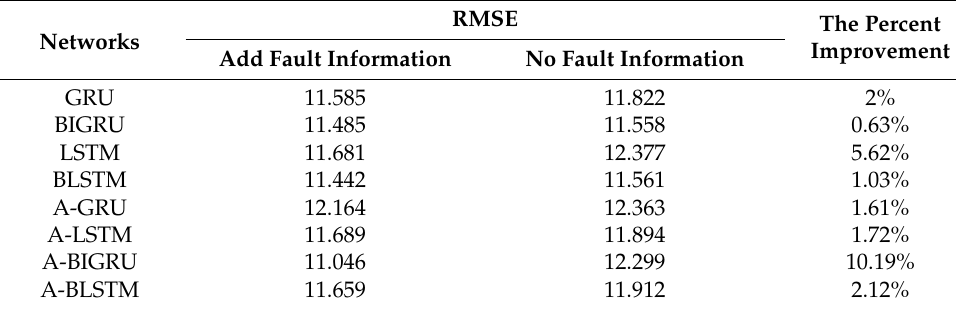
Table 10. Comparison experiment of fault information presence and absence.